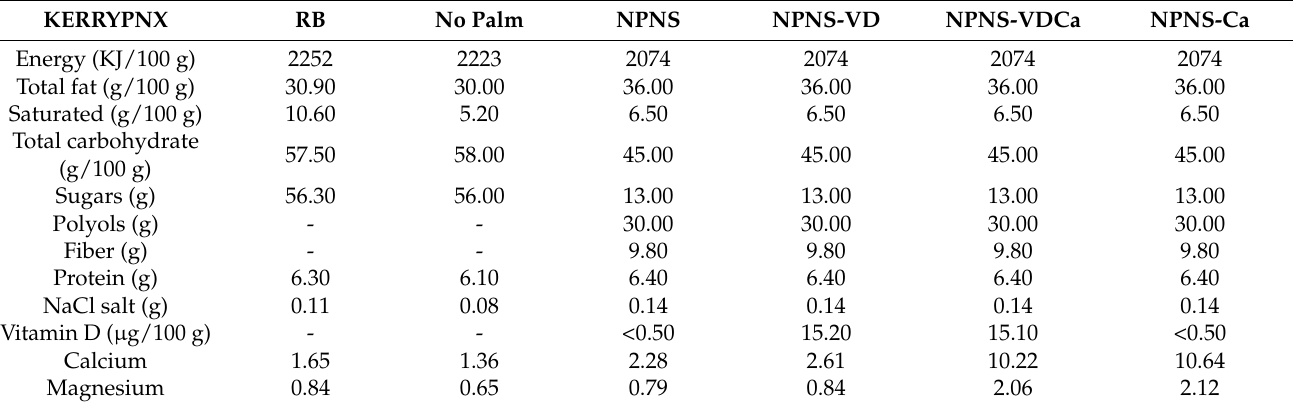
Table 1. Composition of 100 g of formulated chocolate spreads compared with commercially available